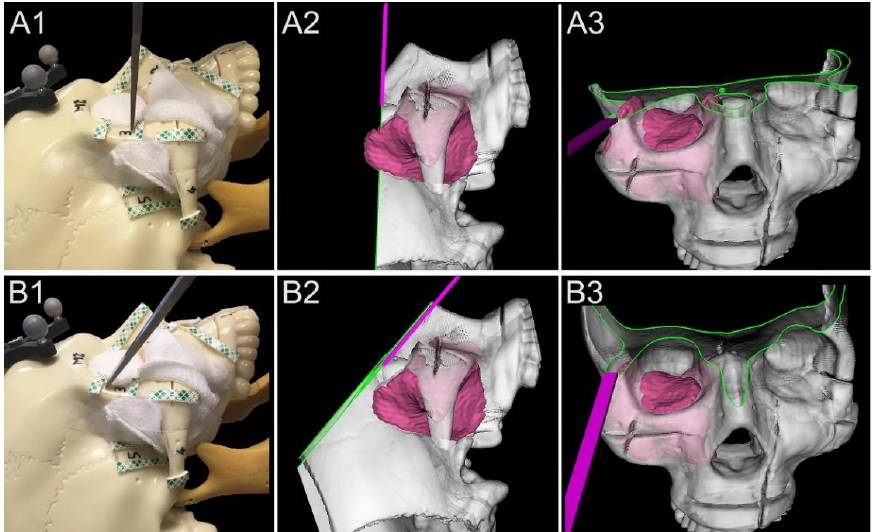
Figure 2. Basic principle of 3D rendering navigation for margin delineation. ( A1 – A3 ). Real lateral view, lateral 3D rendered view, and front 3D rendered view example of an unguided simulation. The virtual cutting plane crosses a portion of the tumor model located into the temporal fossa. ( B1 – B3 ). Real lateral view, lateral 3D rendered view, and front 3D rendered view of navigated simulation. With real-time 3D rendering navigation, the surgeon shifted the osteotome cranially and tilted it parallel to the surface of the tumor (green line shows the intersection between the cutting plane and bone).